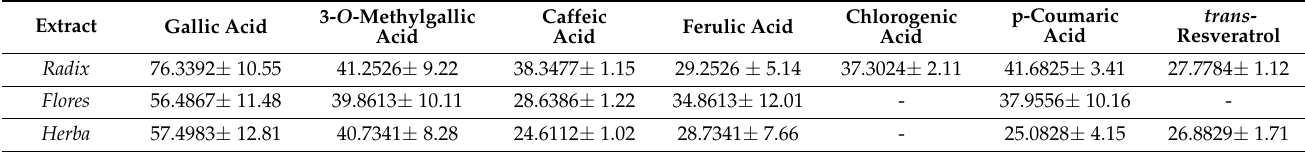
Table 2. Phenolic compounds in the extracts from Lysimachia nummularia L.